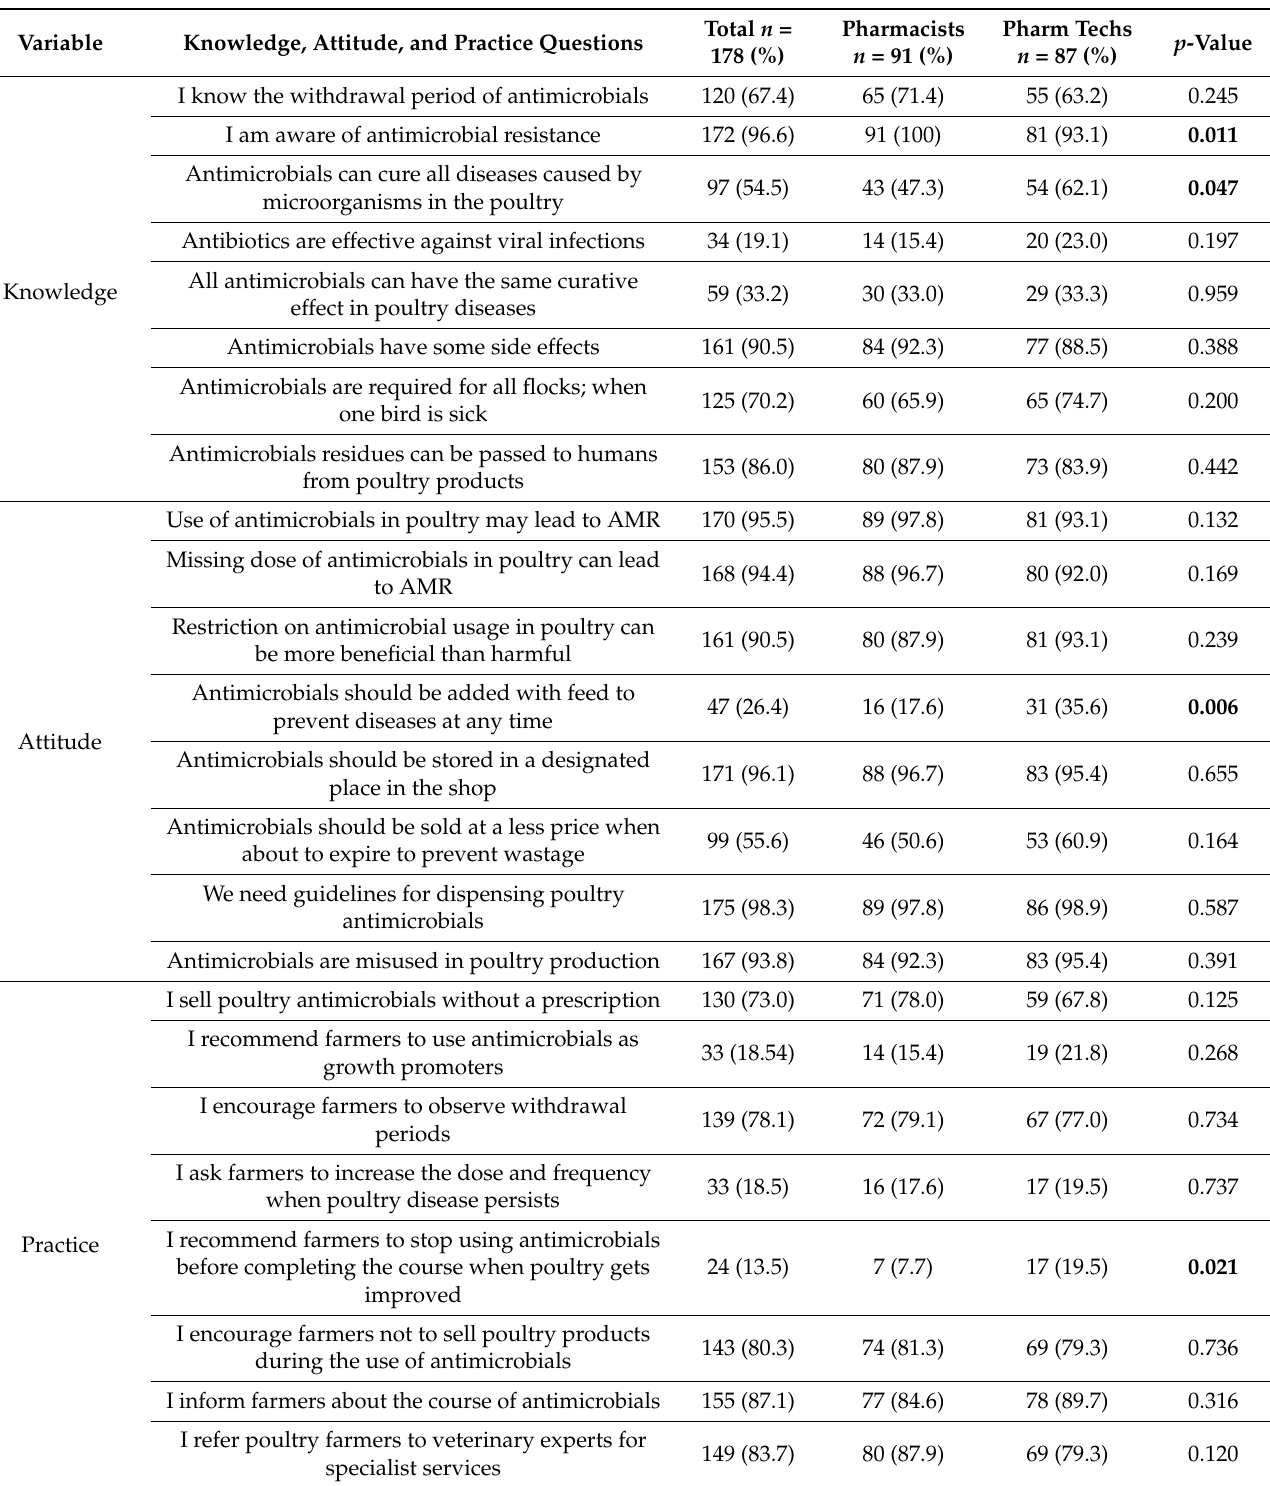
Table 2. The proportion of pharmacists and pharmacy technologists who correctly/positively re- sponded to knowledge, attitudes, and practices questions on poultry ABU and